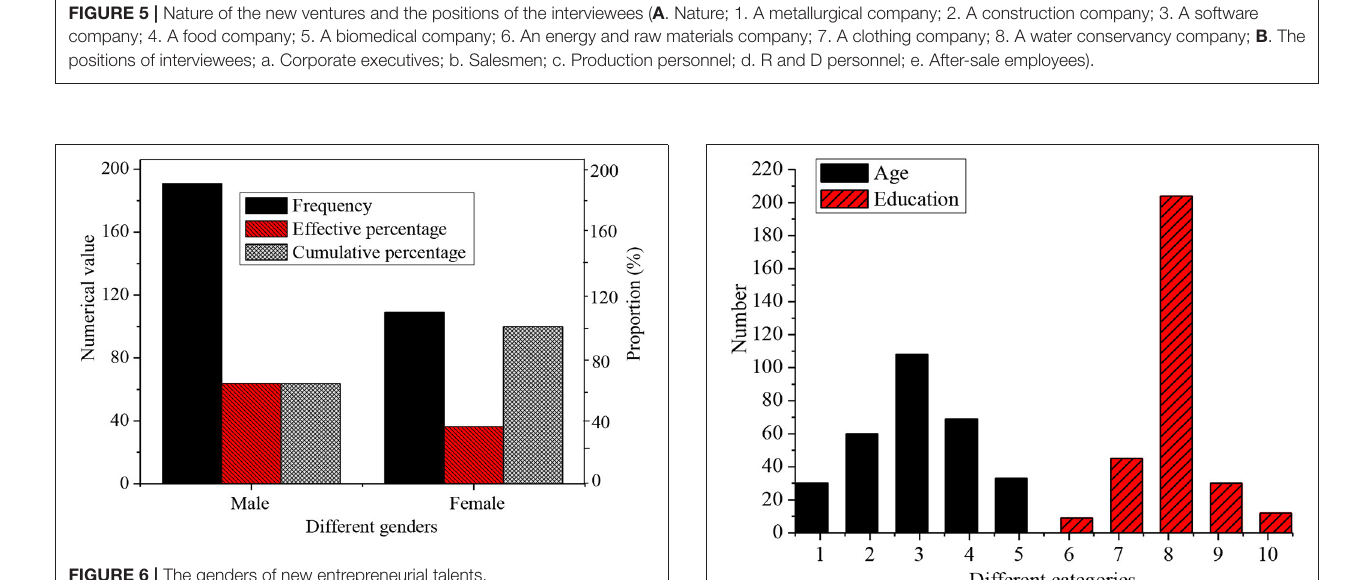
FIGURE 6 | The genders of new entrepreneurial talents.